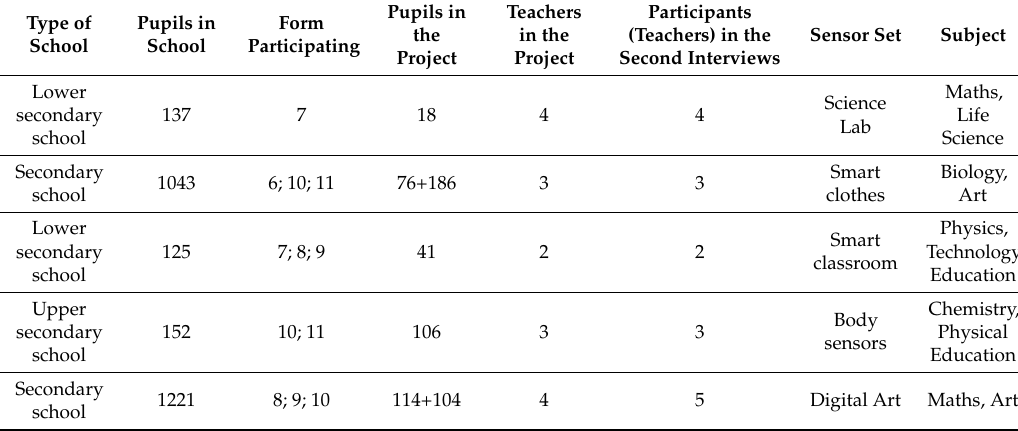
Table 1. Schools in the pilot project.